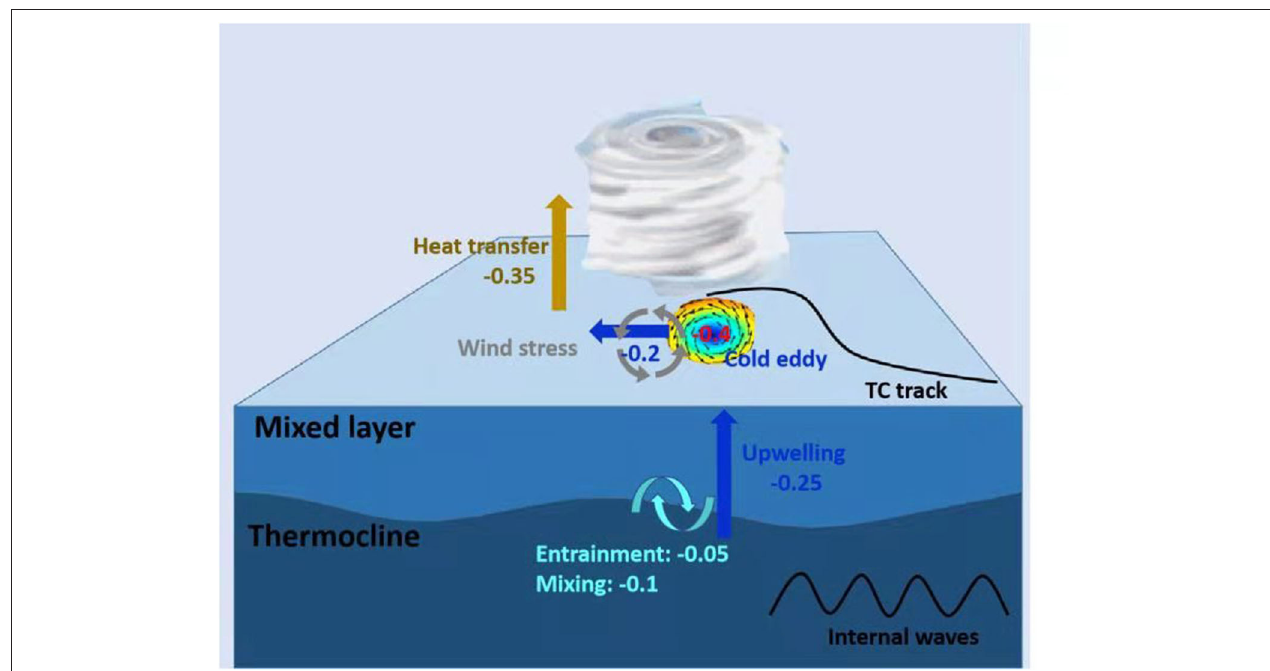
FIGURE 9 | Schematic of physical processes of the extreme surface cooling during TC Bailu. TCs, tropical